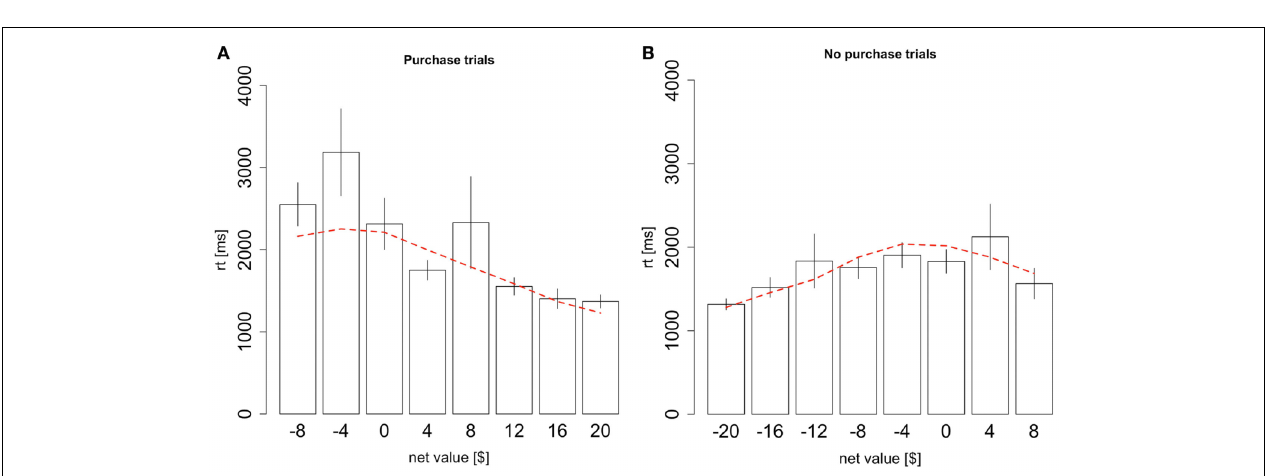
FIGURE 4 | Choice biases. (A) The probability of purchasing the item as a function of the difference in total fixation time (over the whole trial) between the product and the price. Black circles indicate data from the odd-numbered trials of the subject data, and the red dashed line indicates the simulated data